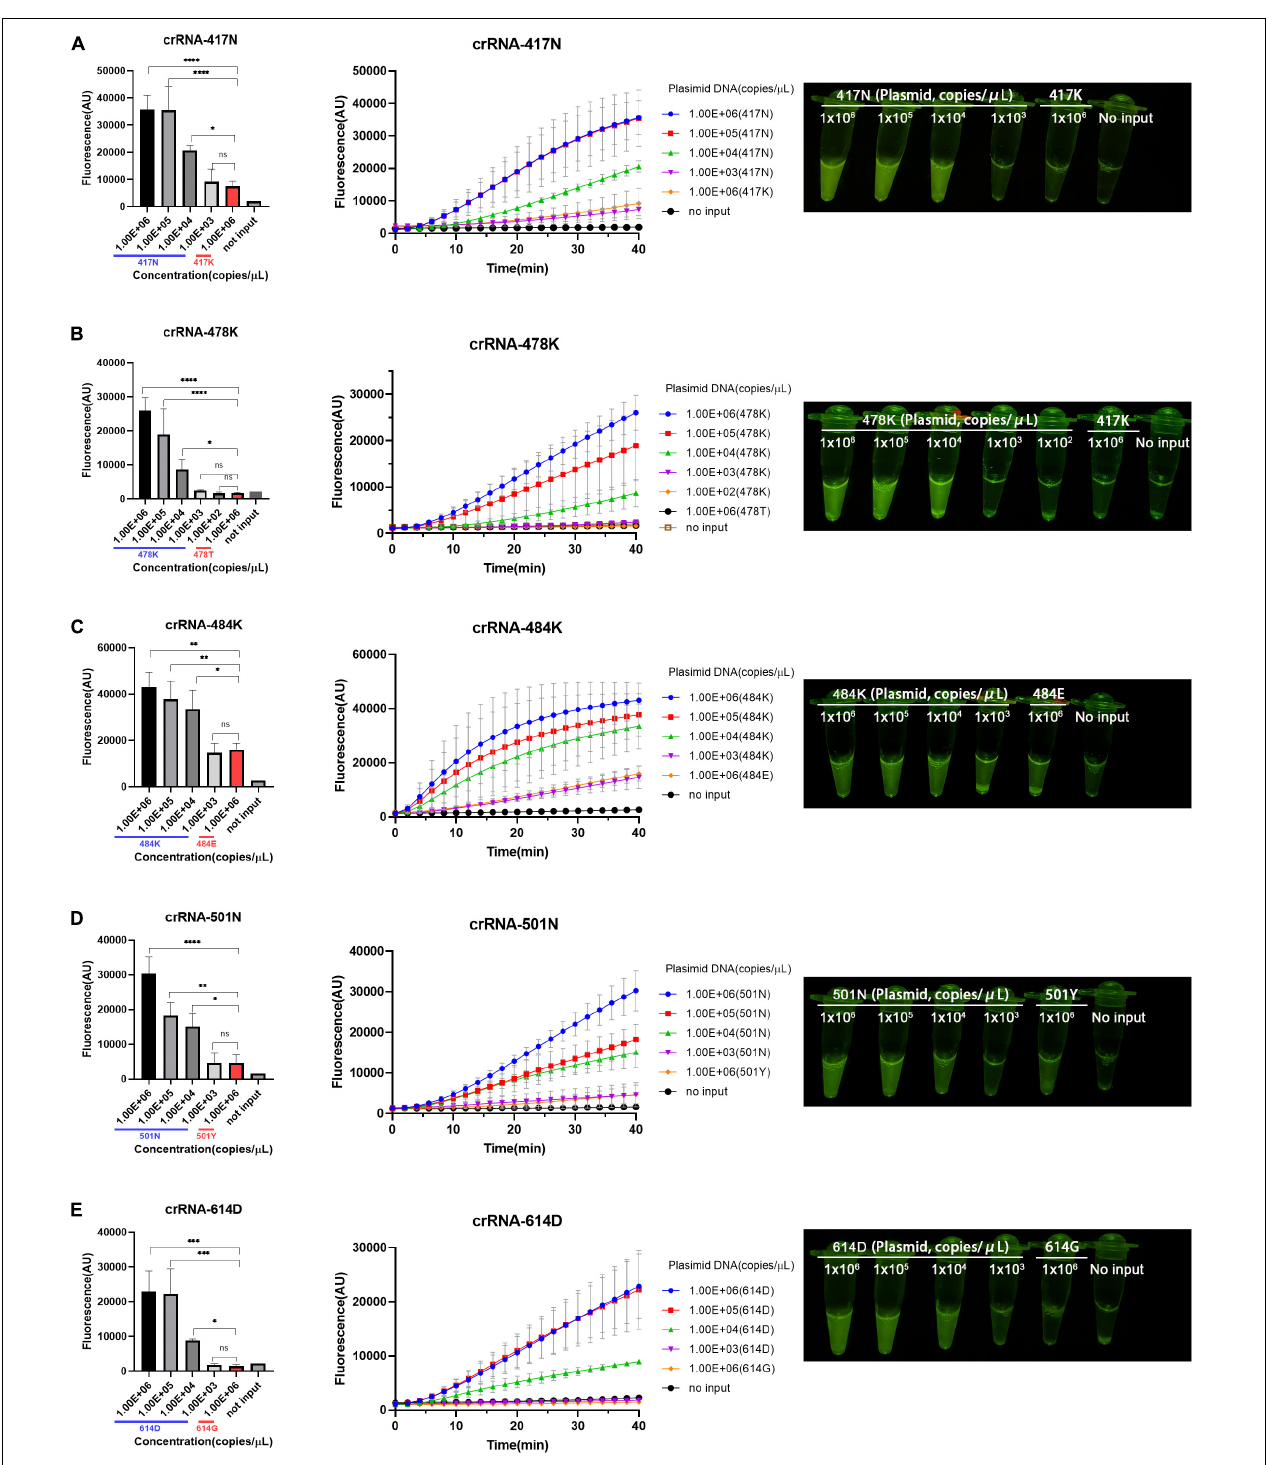
FIGURE 3 | Limit of detection (LOD) of RAA/CRISPR-Cas12a-mediated detection. The LOD was determined and presented for the 5 crRNAs specific for the amino acid 417N (A) , 478K (B) , 484K (C) , 501N (D) , and 614D (E) of SARS-CoV-2 spike protein, respectively. A series of 10-fold diluted synthetic SARS-CoV-2 plasmid DNAs of wild-type (10 2 –10 6 copies/ µ l) and mutant S gene (10 6 copies/ µ l) were used as the templates for RAA followed by the detection of CRISPR-Cas12a-mediated assay. Fluorescence intensity are represented as mean ± standard deviation (SD) of three replicates or read out directly by the naked eye under a blue light imager. No input refers to no DNA template. Two-tailed Mann–Whitney U test was used to analyze the fluorescence difference between on-target and off-target template detected by the RAA/Cas12a-mediated assay. ns, P > 0.05; ∗ P < 0.05; ∗∗ P < 0.01; ∗∗∗ P < 0.001; ∗∗∗∗ P < 0.0001.